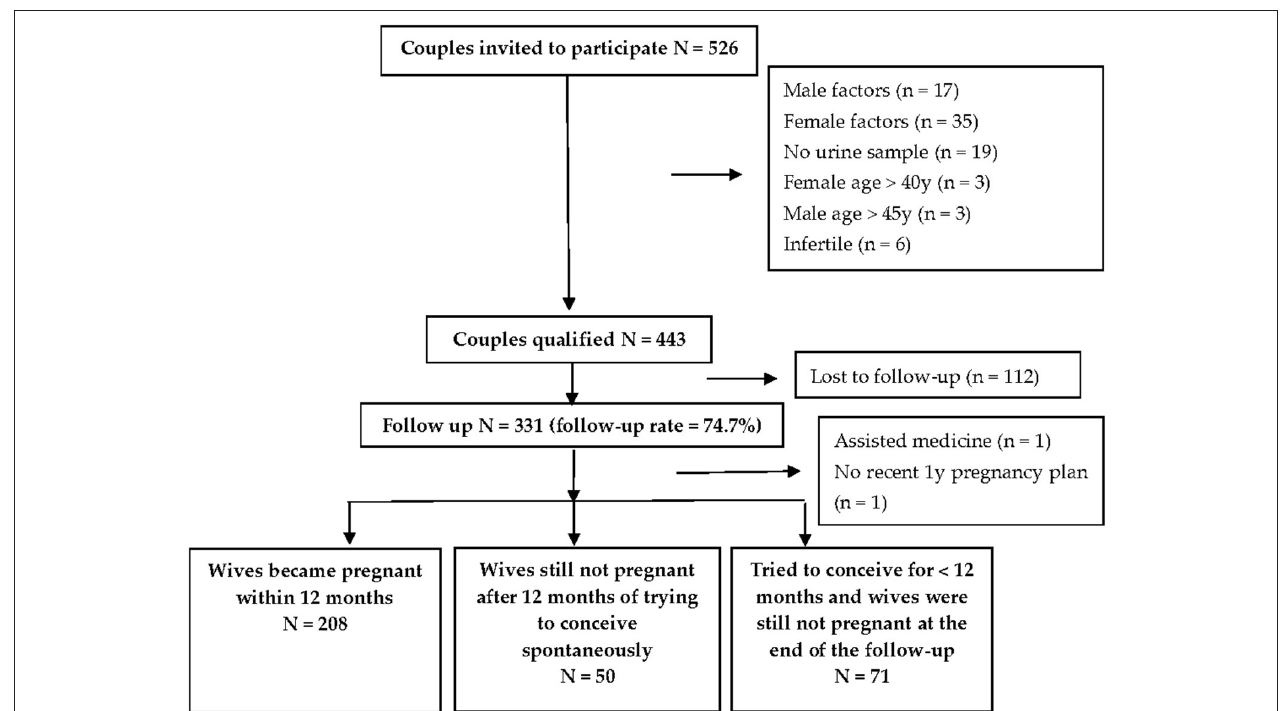
FIGURE 1 | The inclusion and exclusion of participants in the